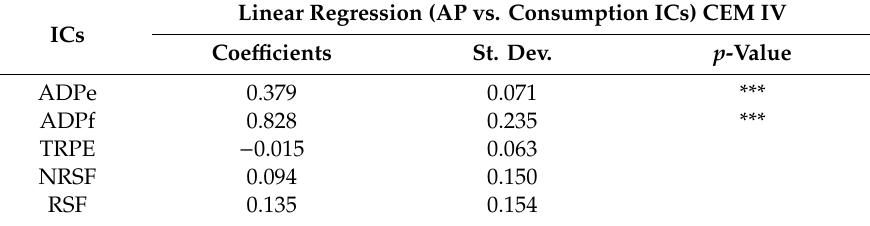
Table 21. AIC selection for GWP regression summary—CEM